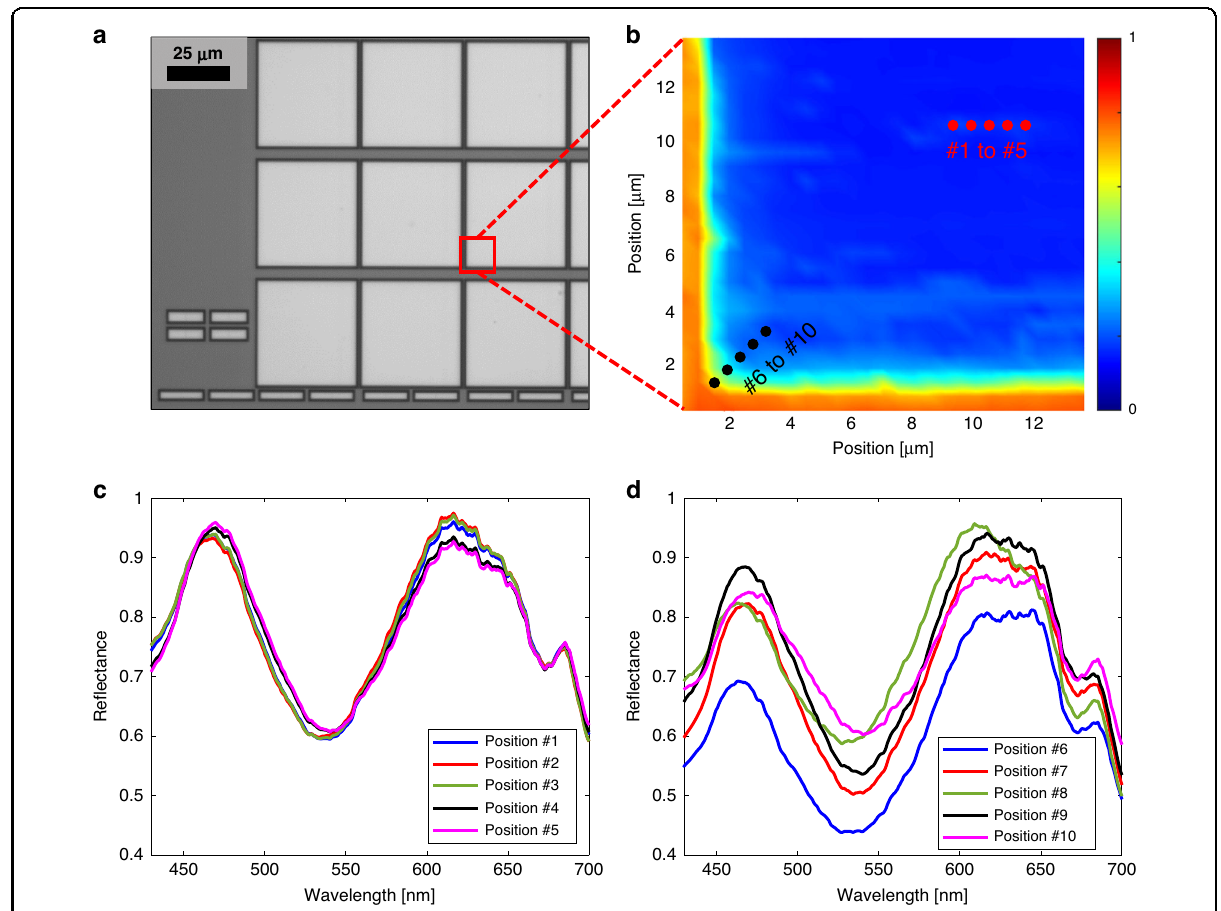
Fig. 10 Spectrum measurement result of the edges and corner areas of cell blocks. a ×20 image of DRAM cell array. b Principal component analysis map of the re fl ectance obtained by MASR. The red dots (#1 to #5) refer to the center positions of the cell block, while the black dots (#6 to #10) refer to the edge area from the outside of the cell block. c Spectral re fl ectance for positions #1 to #5 and d #6 to #10 in b